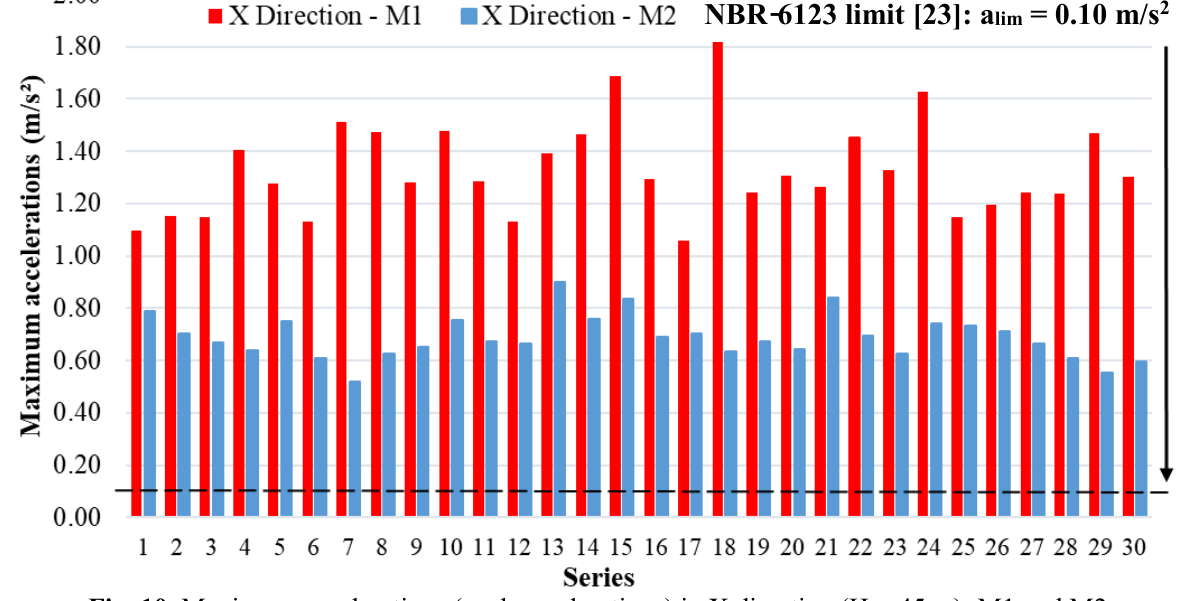
Fig. 10. Maximum accelerations (peak accelerations) in X direction (H = 45 m): M1 and